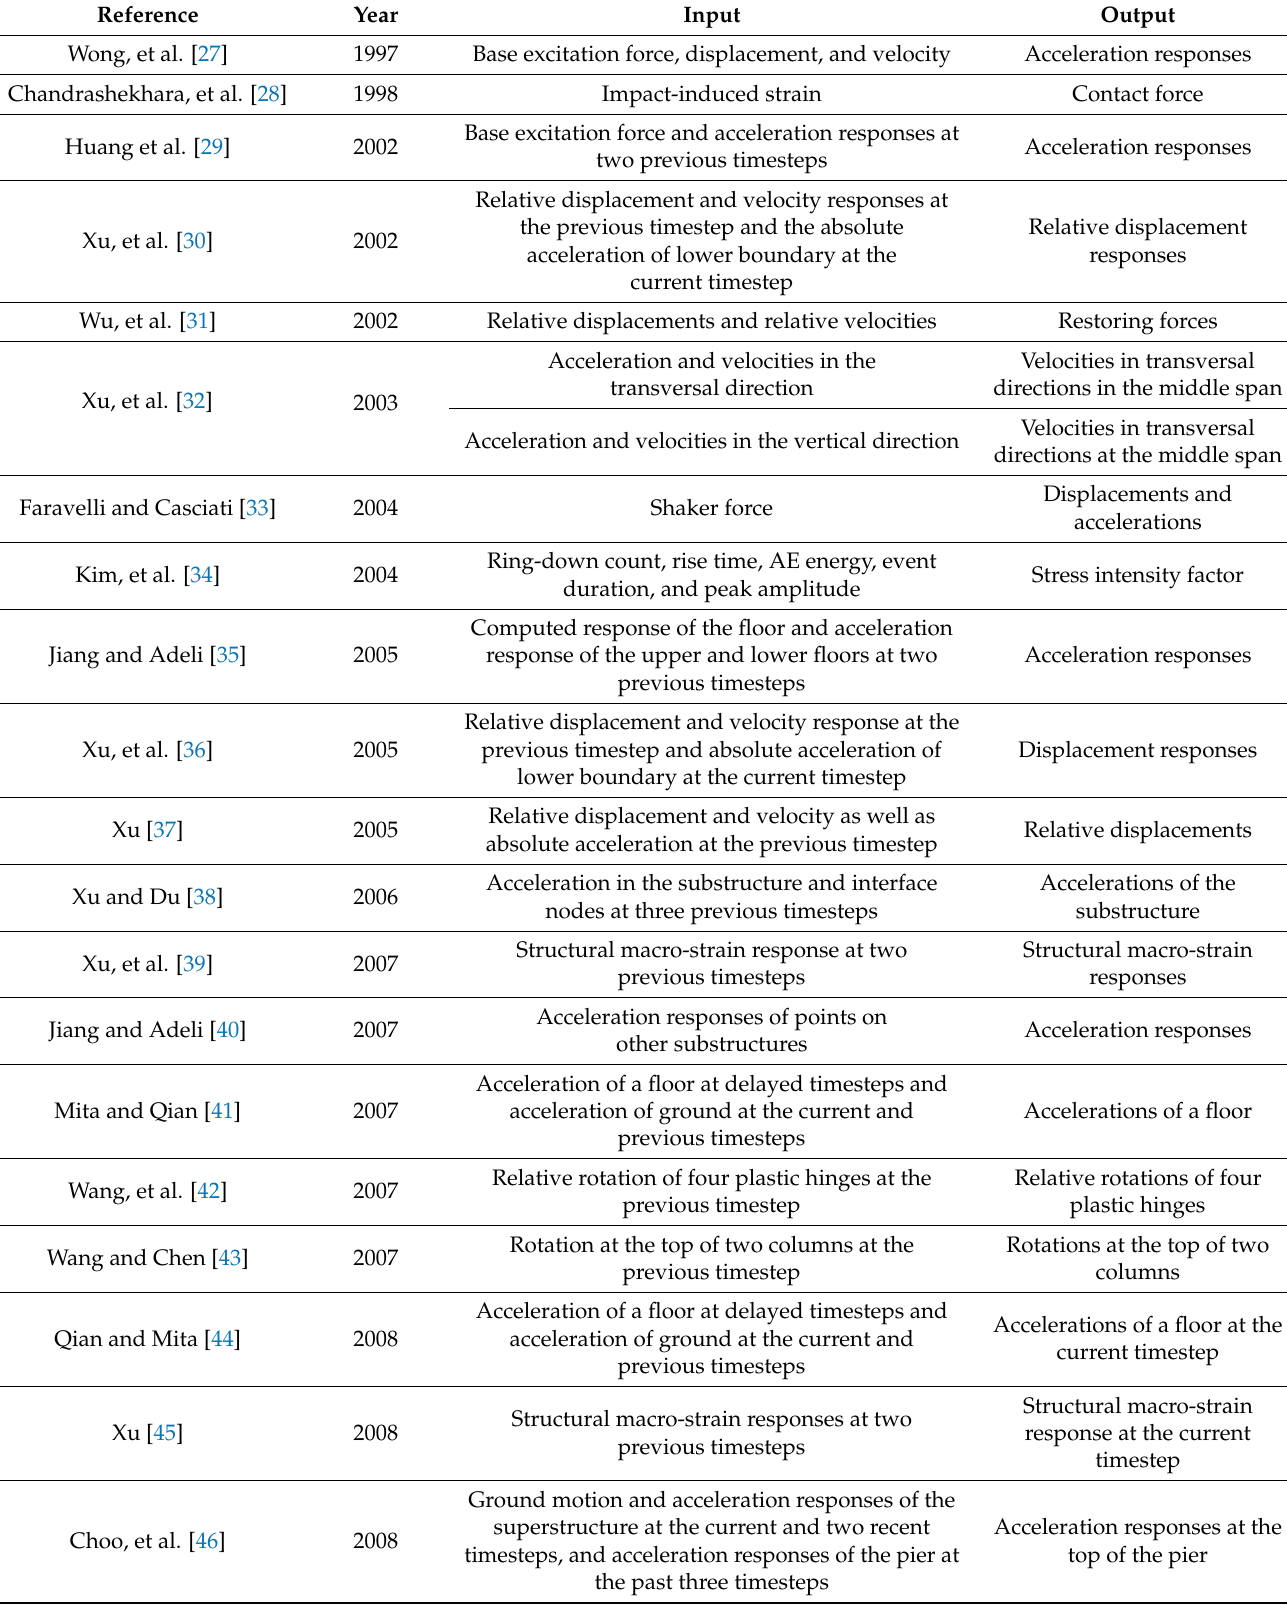
Table 1. Inputs and outputs of nonparametric surrogate